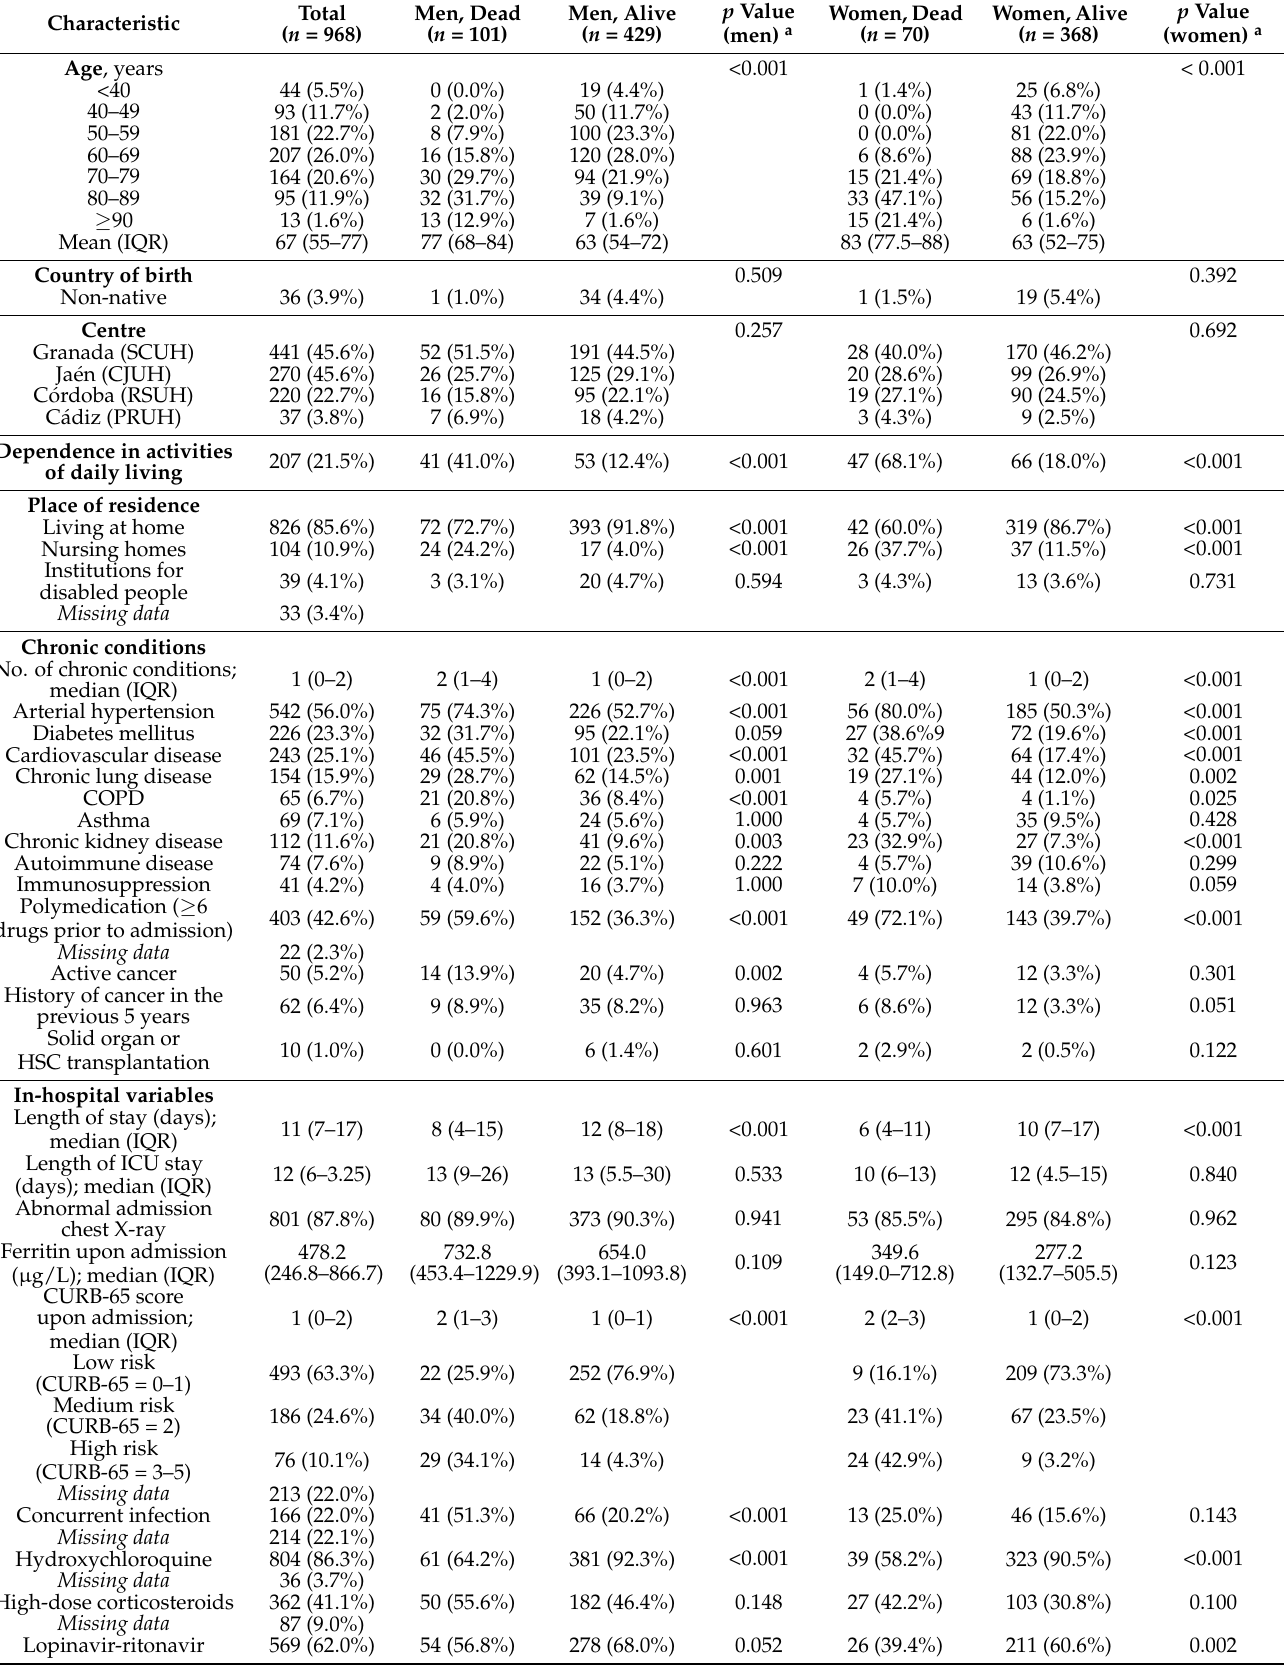
Table 1. Characteristics of patients hospitalised with COVID-19, stratified by